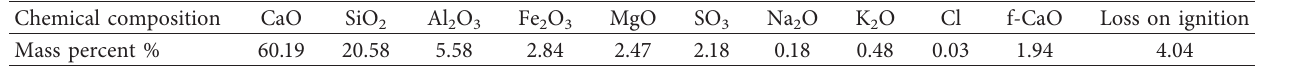
Table 5: Chemical composition of cement.